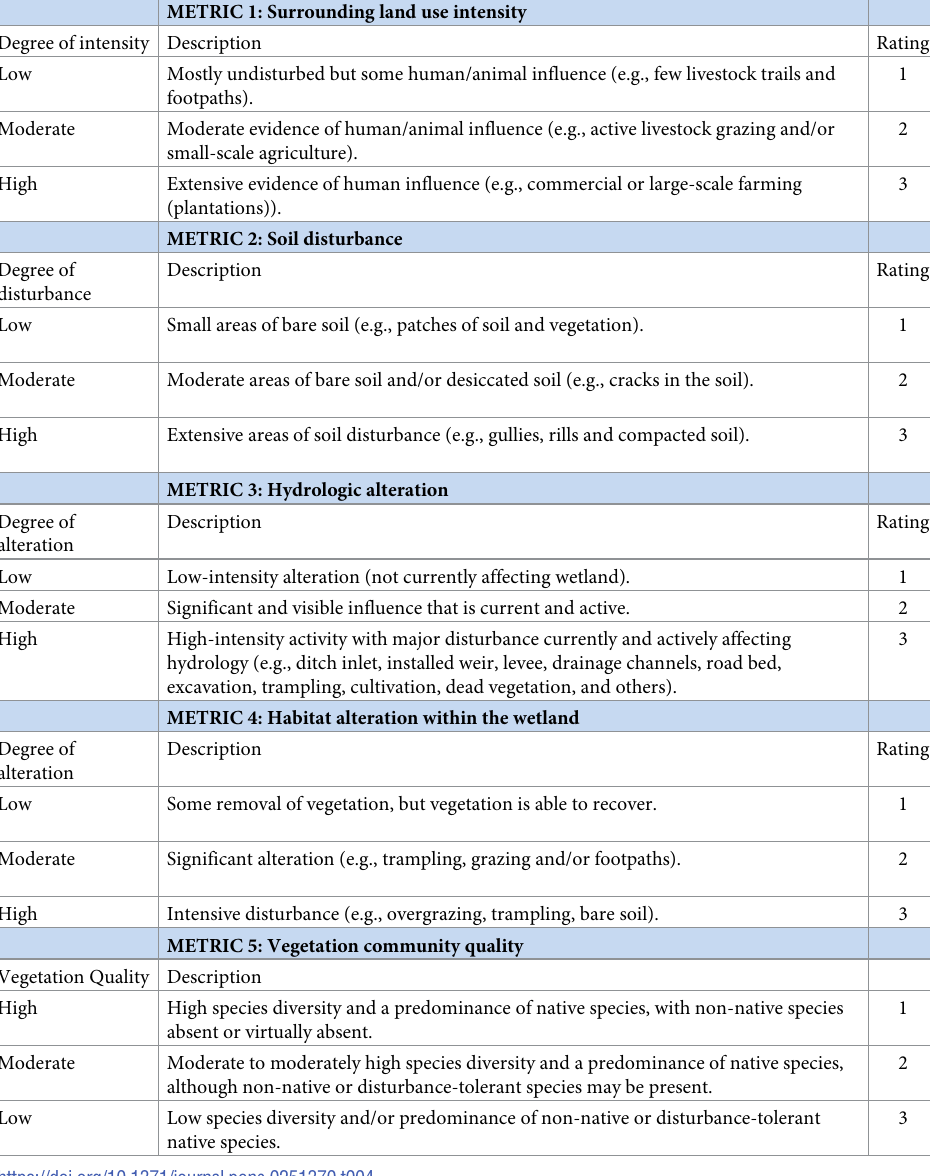
Table 4. Anthropogenic Activity Index (AAI) for the Tsitsa River catchment, adapted from [11]. METRIC 1: Surrounding land use